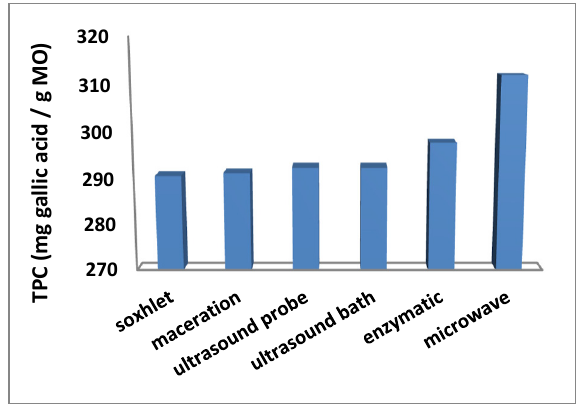
Fig. 1. Evaluation of various extraction methods on TPC